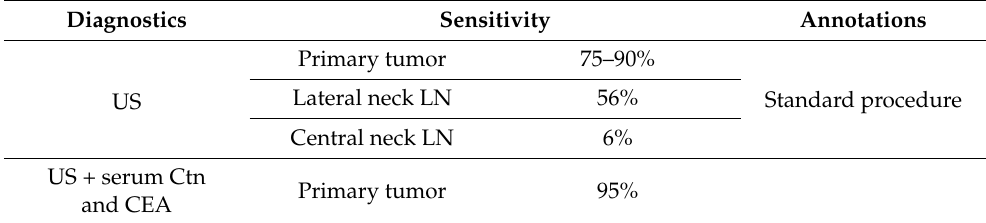
Table 3. Comparison of the sensitivity of MTC